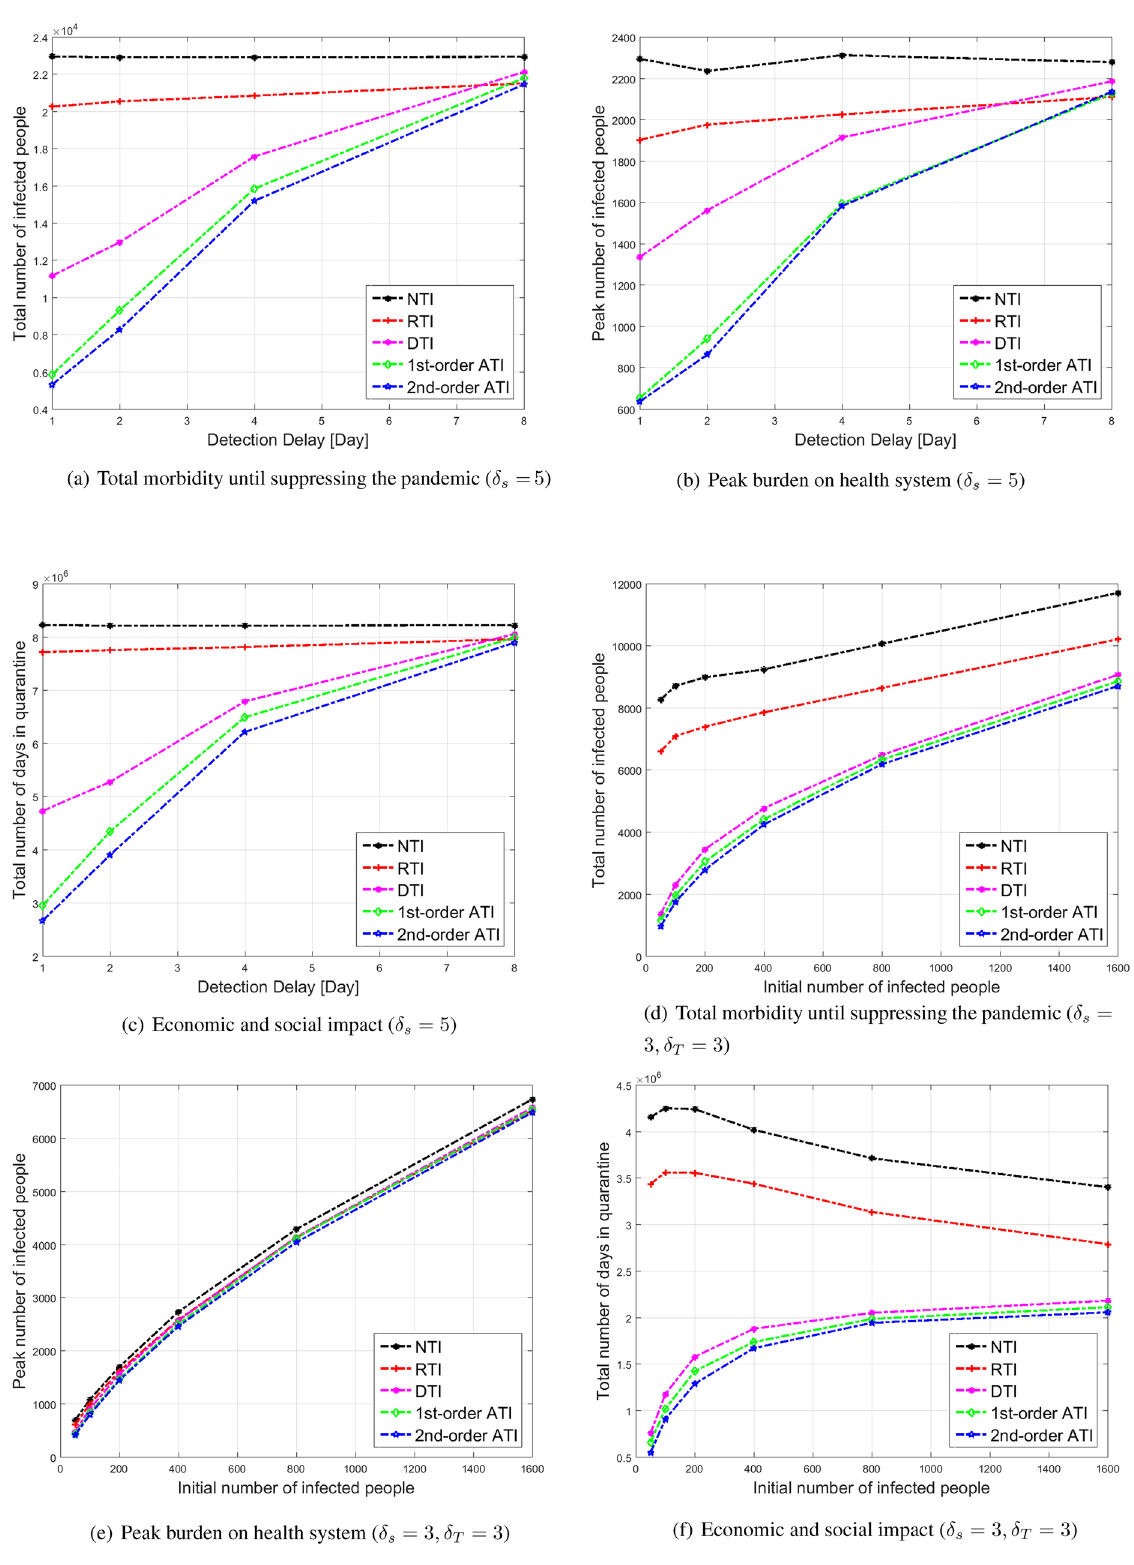
Figure 4. Simulation results for a COVID-19 outbreak in a population of 100,000 people. Daily testing capacity is set to